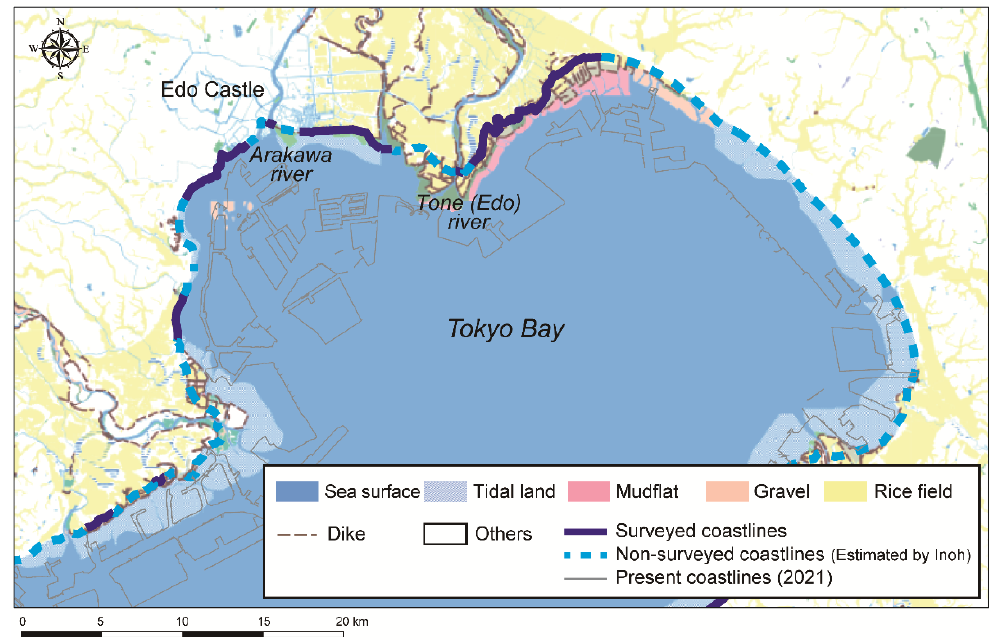
Figure 10. Overlaying of the non-surveyed coastline and land use maps (1881 – 1882). The land use classification is based on the 1st Military District 1:20,000 Jinsoku-Sokuzu map. Source: Digital Inoh ’ s Map and Geospatial Information Authority of Japan.